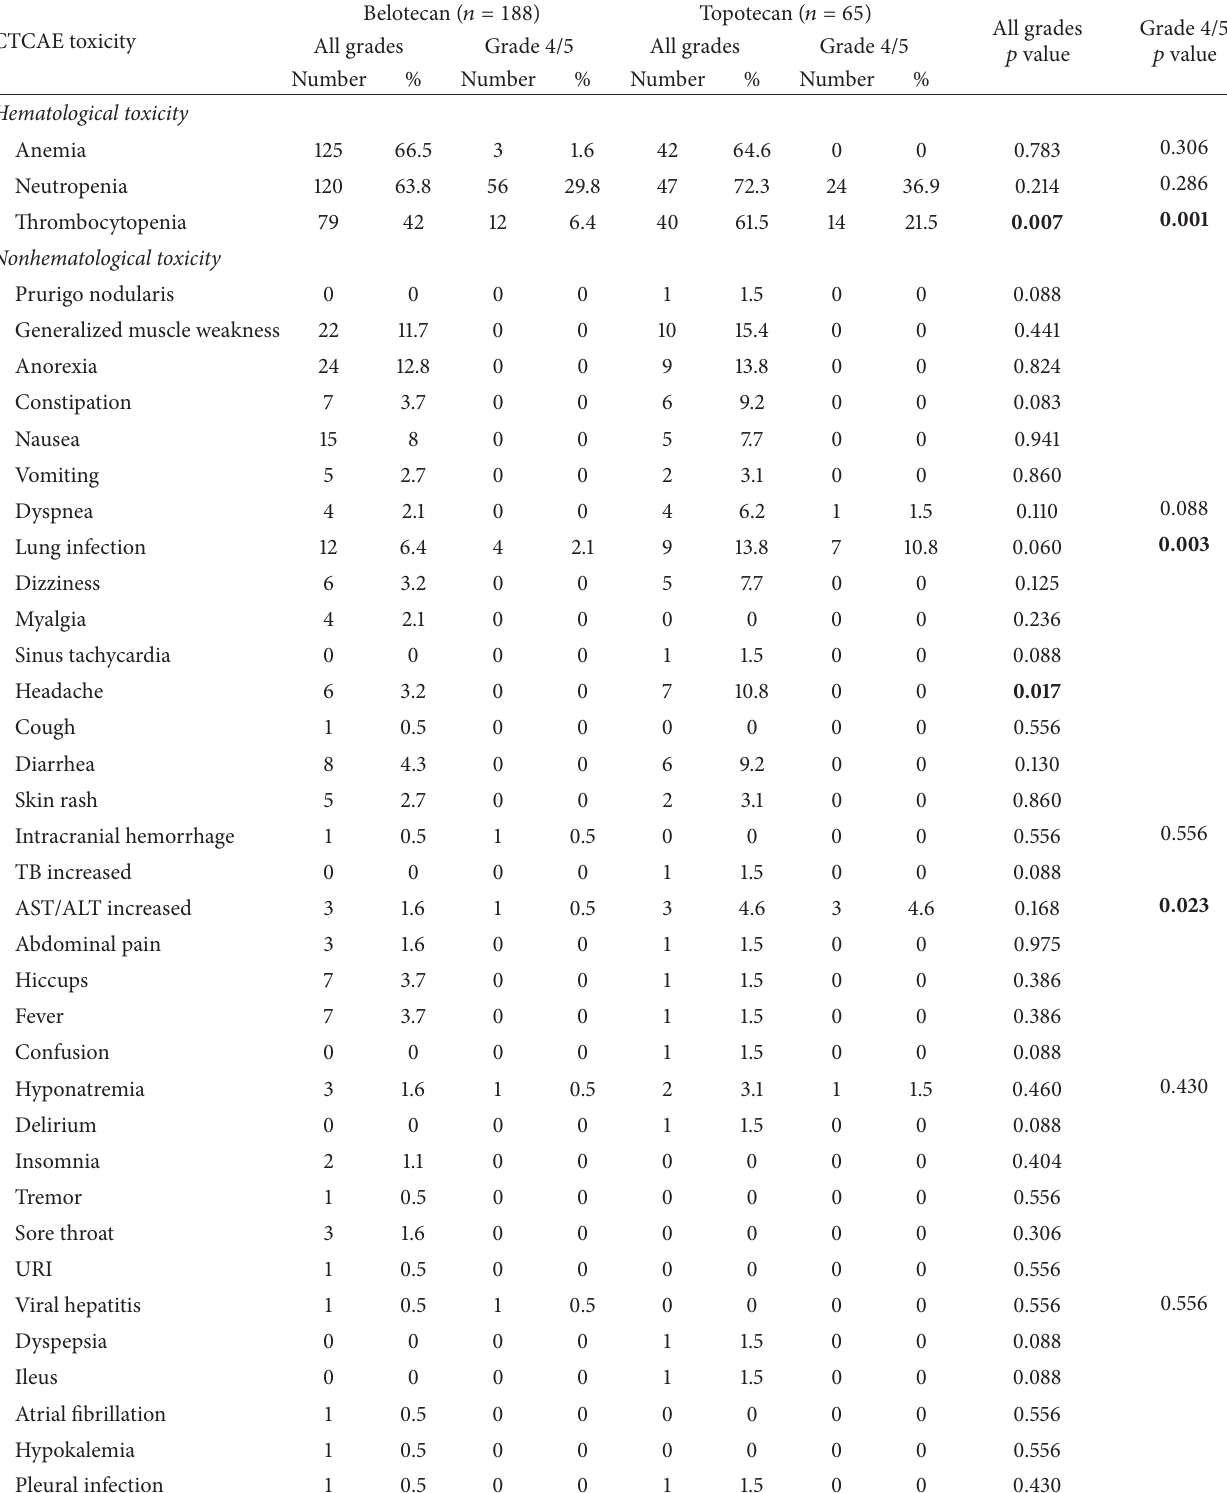
Table 3: Toxicities (CTCAE version